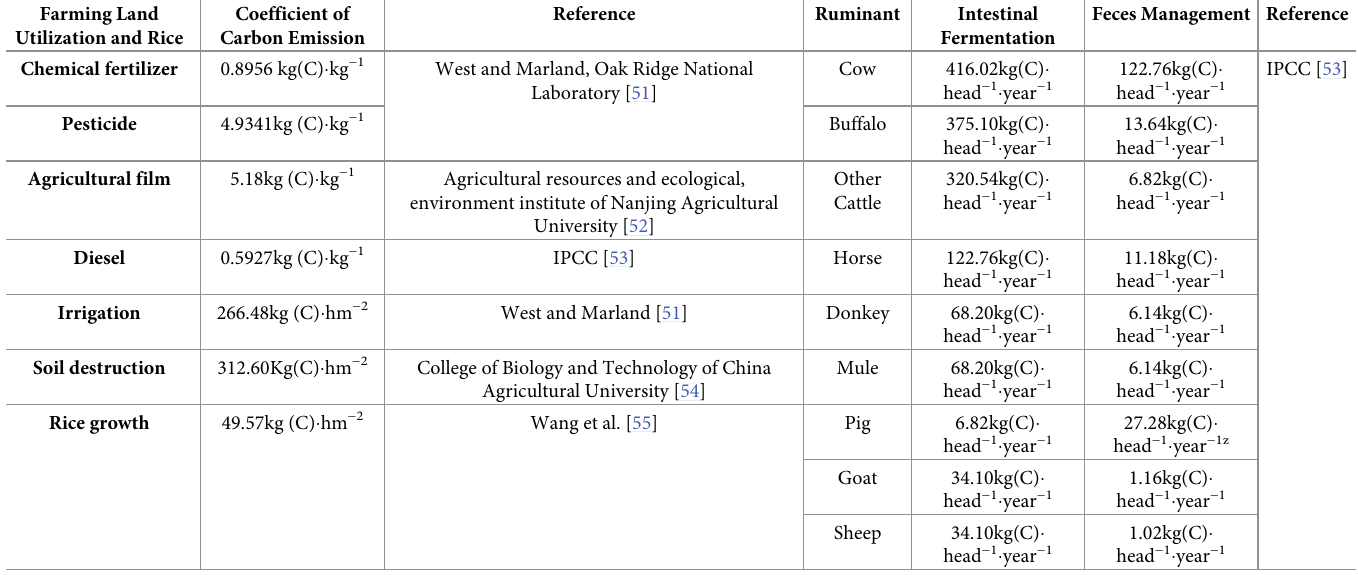
Table 1. Carbon emission coefficients of various agricultural carbon